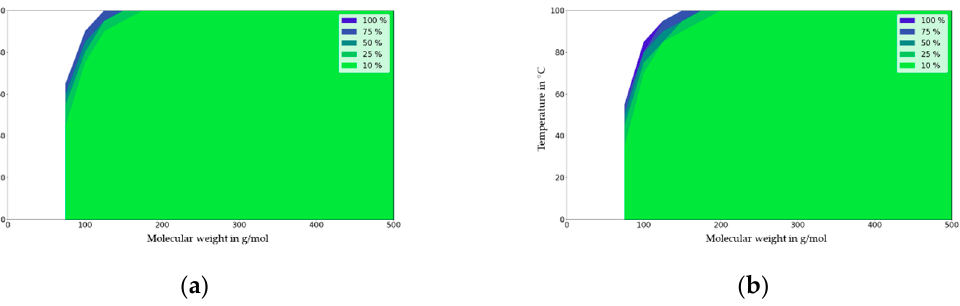
Figure 9. Migration map for ABS for contact times of 1 day ( a ) and 10 days ( b ). Molecular weight in g/mol against temperature (T) in °C. Deviation of migration in mg/dm 2 independent of partition coefficient (K P,F ) expressed in % at a given initial concentration (1000 mg/kg), material thickness (2000 µm), and area to volume ratio (6 dm 2 per kg food).